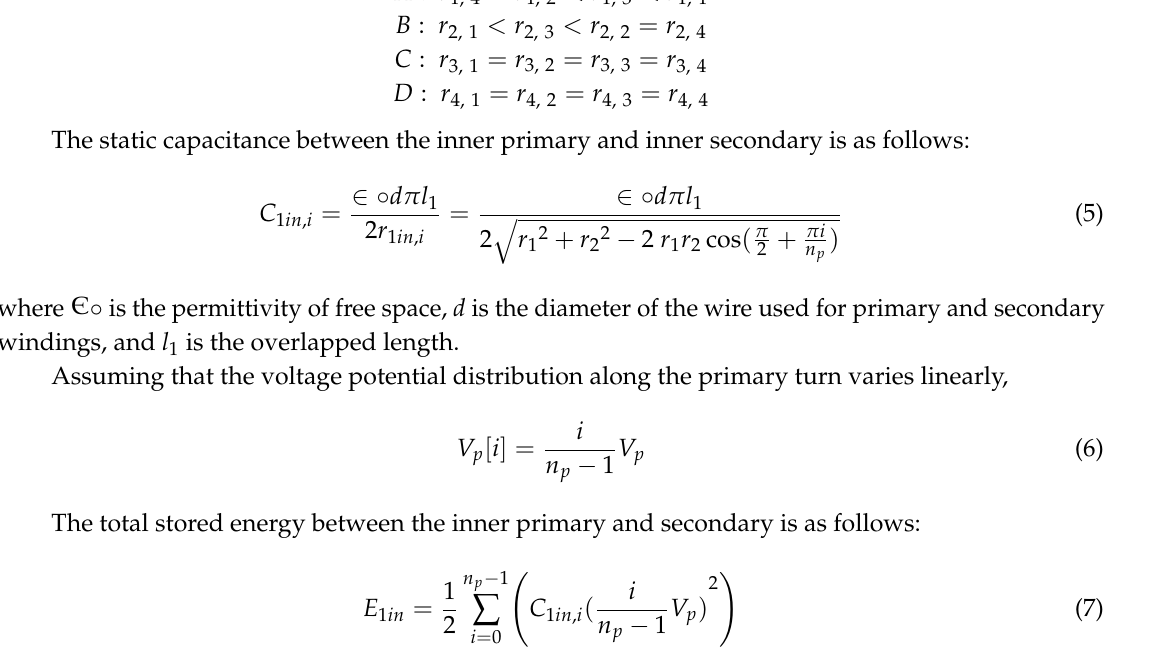
Table 4. Detailed parameters of the transformer prototypes. PLA—polylactic acid.